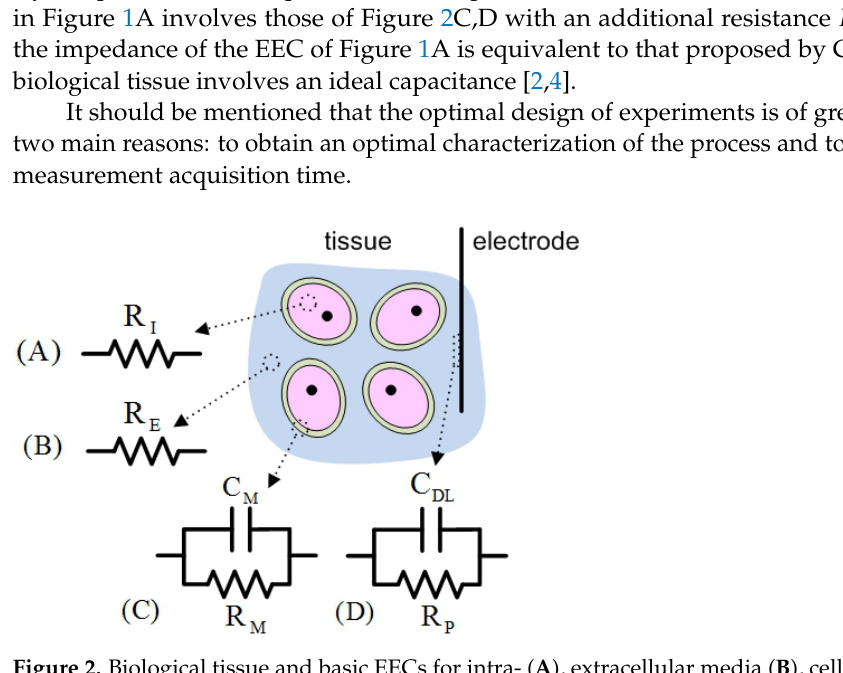
Figure 2. Biological tissue and basic EECs for intra- ( A ), extracellular media ( B ), cell membrane ( C ), and electrode-tissue interface ( D